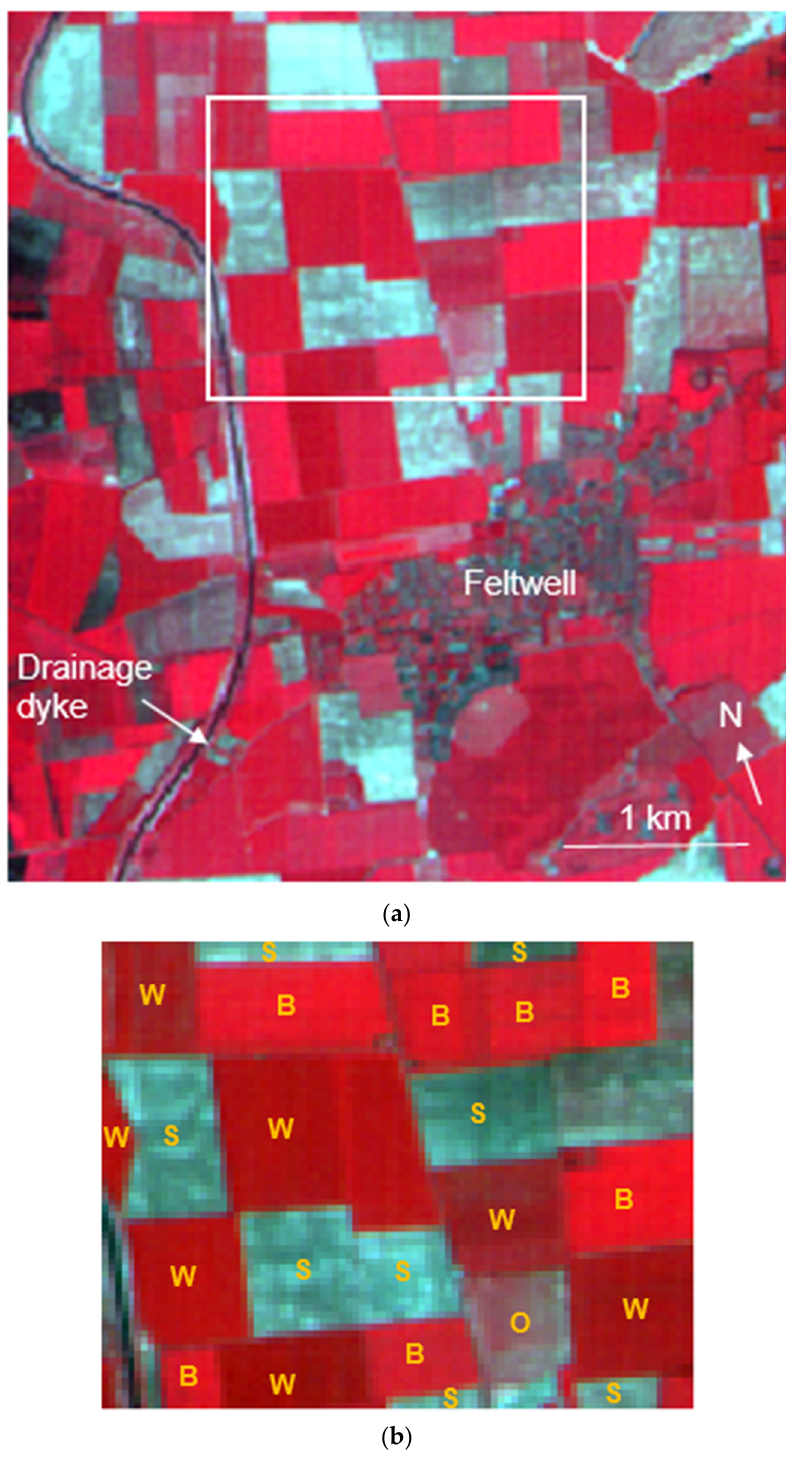
Figure 1. False colour composite SPOT HRV imagery. ( a ) regional setting and context around the village of Feltwell, UK. The white box illustrates the extract used to illustrate the potential of latent class analysis for provision of local information on classification quality and ( b ) the extract used with class labels (B, S and W) annotated; the location labelled O is discussed in the text. Image copyright CNES (2020), reproduced by GMF under licence from SPOT